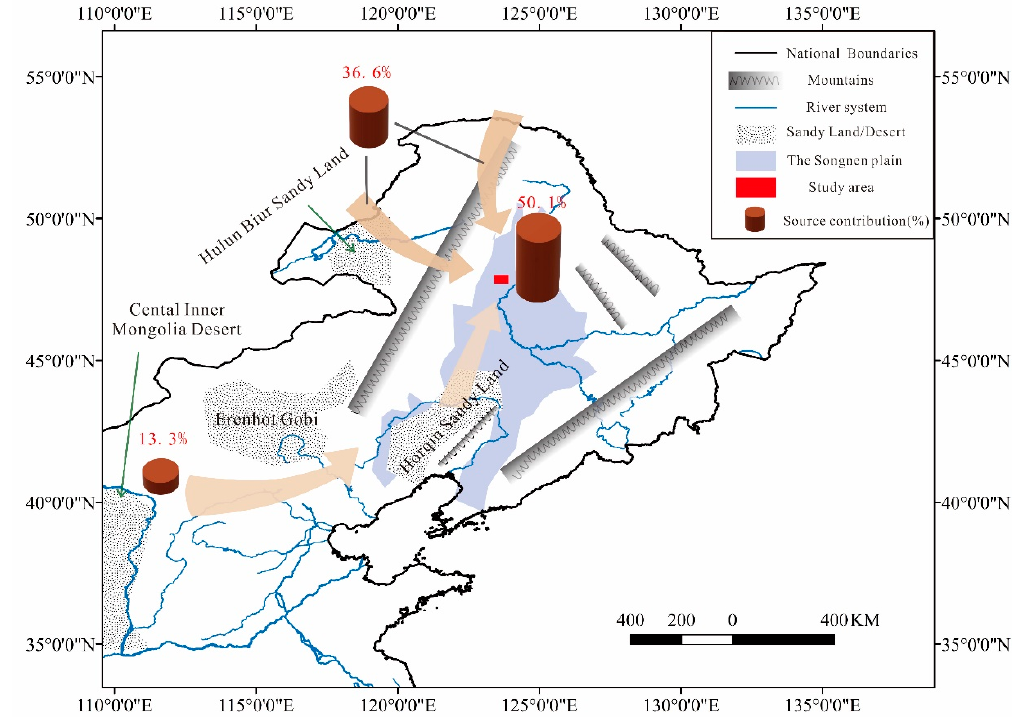
Figure 1. Sampling sites and the schematic diagram of the different sources of atmospheric deposition in the Gannan County area, Northeastern China (N and E refer to north latitude and east longitude respectively).